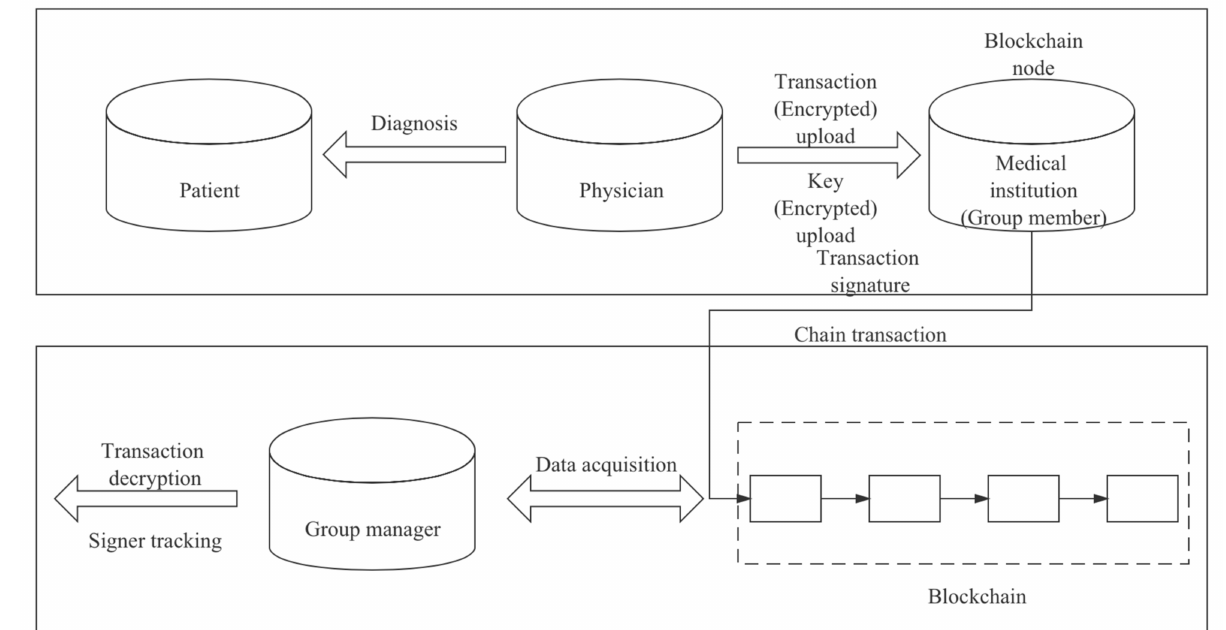
Figure 1. Requirement